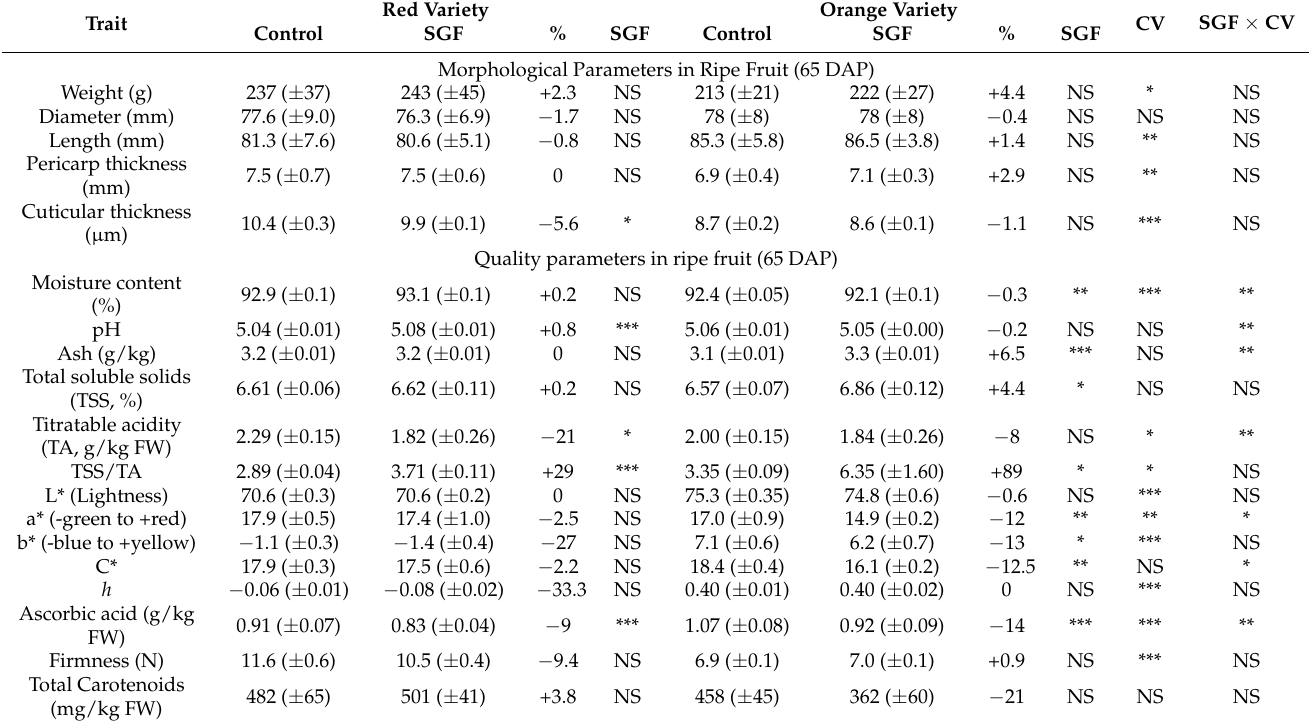
Table 1. Effects of SGF and cultivar interactions on morphology and postharvest quality traits from Red and Orange mature ripe fruits (65 DAP). Data represents the average from multiple fruits ( n = 12) and the standard error of mean is displayed in brackets. Statistical analyses were performed using a one-way ANOVA (*: p ≤ 0.05, **: p ≤ 0.01, and ***: p ≤ 0.001). Abbreviations: